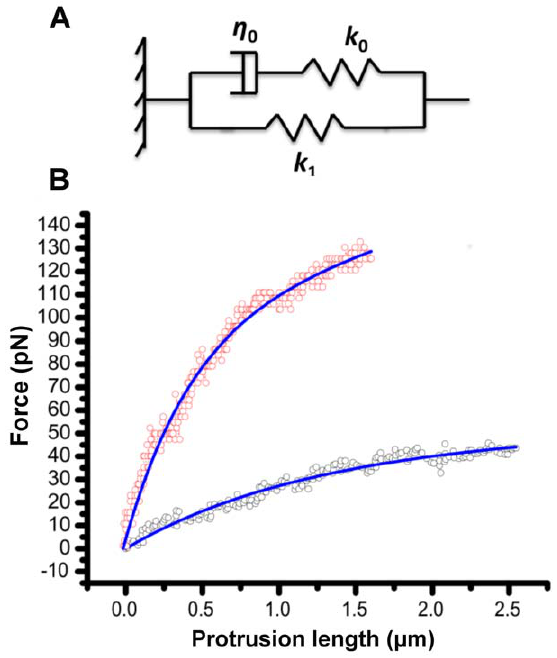
Figure 3. Cell protrusions as a viscoelastic structure. ( A ) Standard linear solid (SLS) model of the protrusion. The model includes a Maxwell arm (viscous coefficient of g 0 in series with spring with stiffness k 0 ) in parallel with a spring with stiffness k 1 . ( B ) Two illustrative force-length profiles of protrusion elongation fitted with the SLS model (blue solid lines). The red circles show data for a cell with intact F-actin and normal membrane cholesterol content. Data in black circles are from cells with disrupted F-actin using Latrunculin-A, but with and normal membrane cholesterol level.